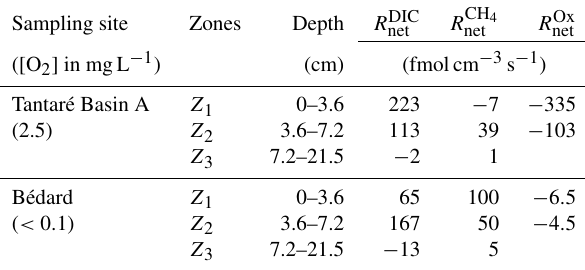
Table 2. Net production rates ( R solute net ) of CH 4 , DIC, and oxidants obtained with the code PROFILE in the three CH 4 consumption and production zones ( Z 1 , Z 2 , and Z 3 ) for both sampling sites.